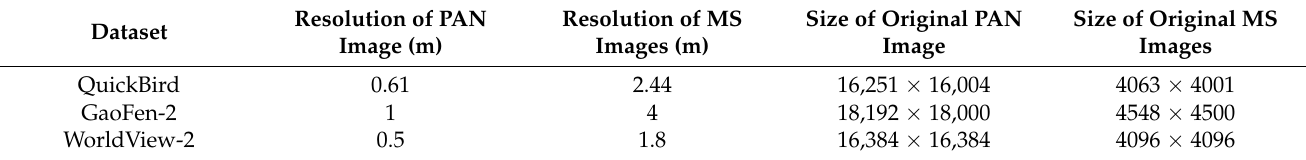
Table 1. Image resolution and size of the original images for QuickBird, GaoFen-2, and WorldView-2. Resolution of PAN Dataset Image